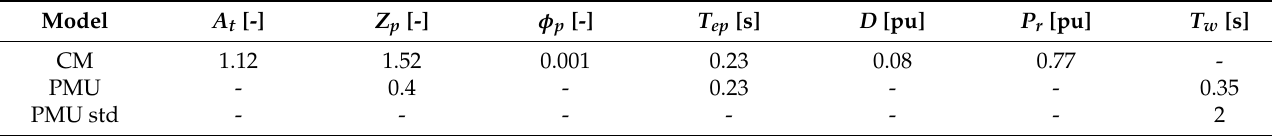
Table 2. Parameters related to different models of the